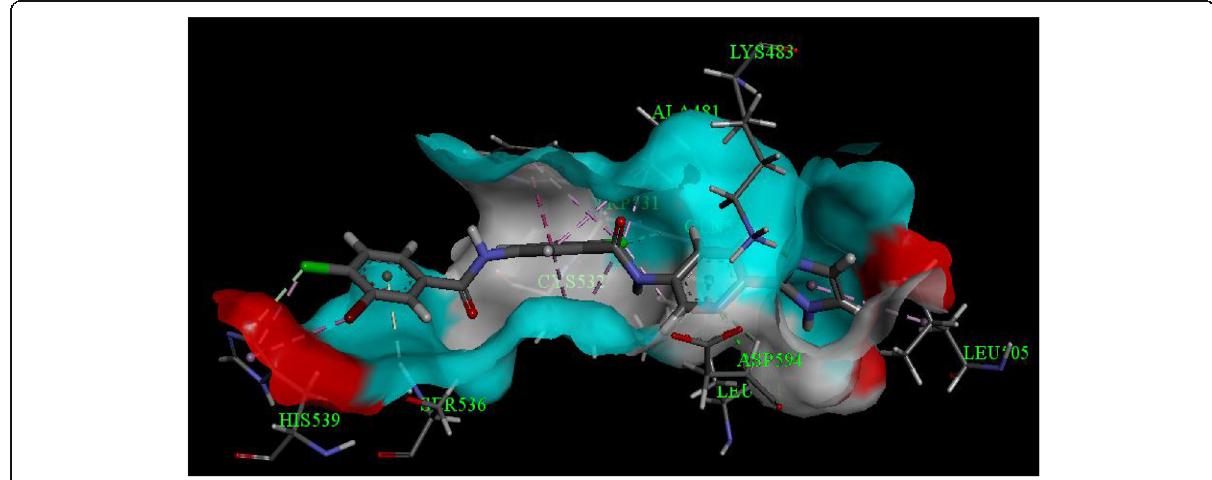
Fig. 3 3D diagram for the interaction of compound 26 with